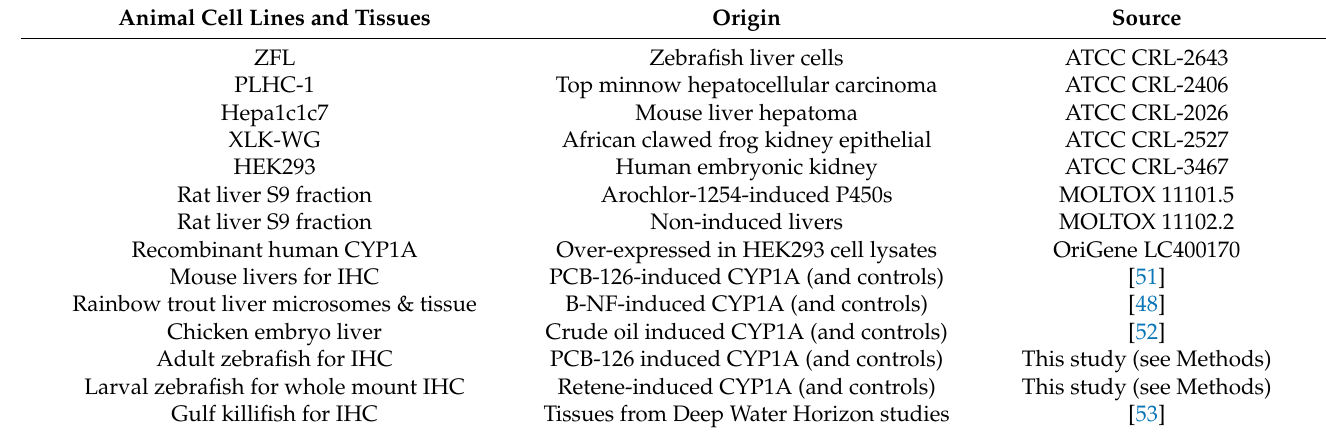
Table 2. Cells and tissues used in this study. Cells were grown and maintained as directed from the source or as modified (see Methods). Tissues from laboratory or environmentally exposed animals were processed for either tissue sub fractionation, formalin fixation and paraffin embedding followed by immunohistochemistry (IHC), or whole-mount IHC as described in the Methods section. Referenced sources were archived samples from previous studies (see